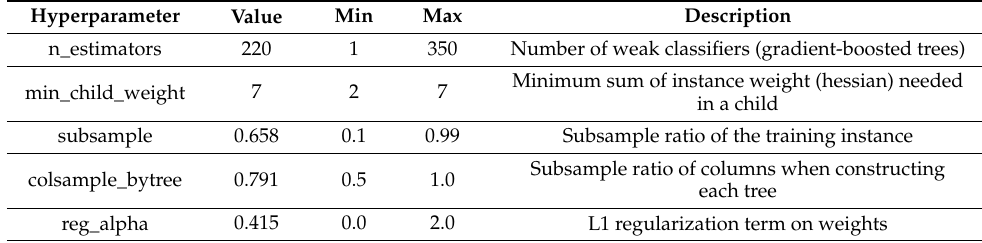
Figure 7. Flow chart representing the XGBoost classifier hyperparameter optimization process.